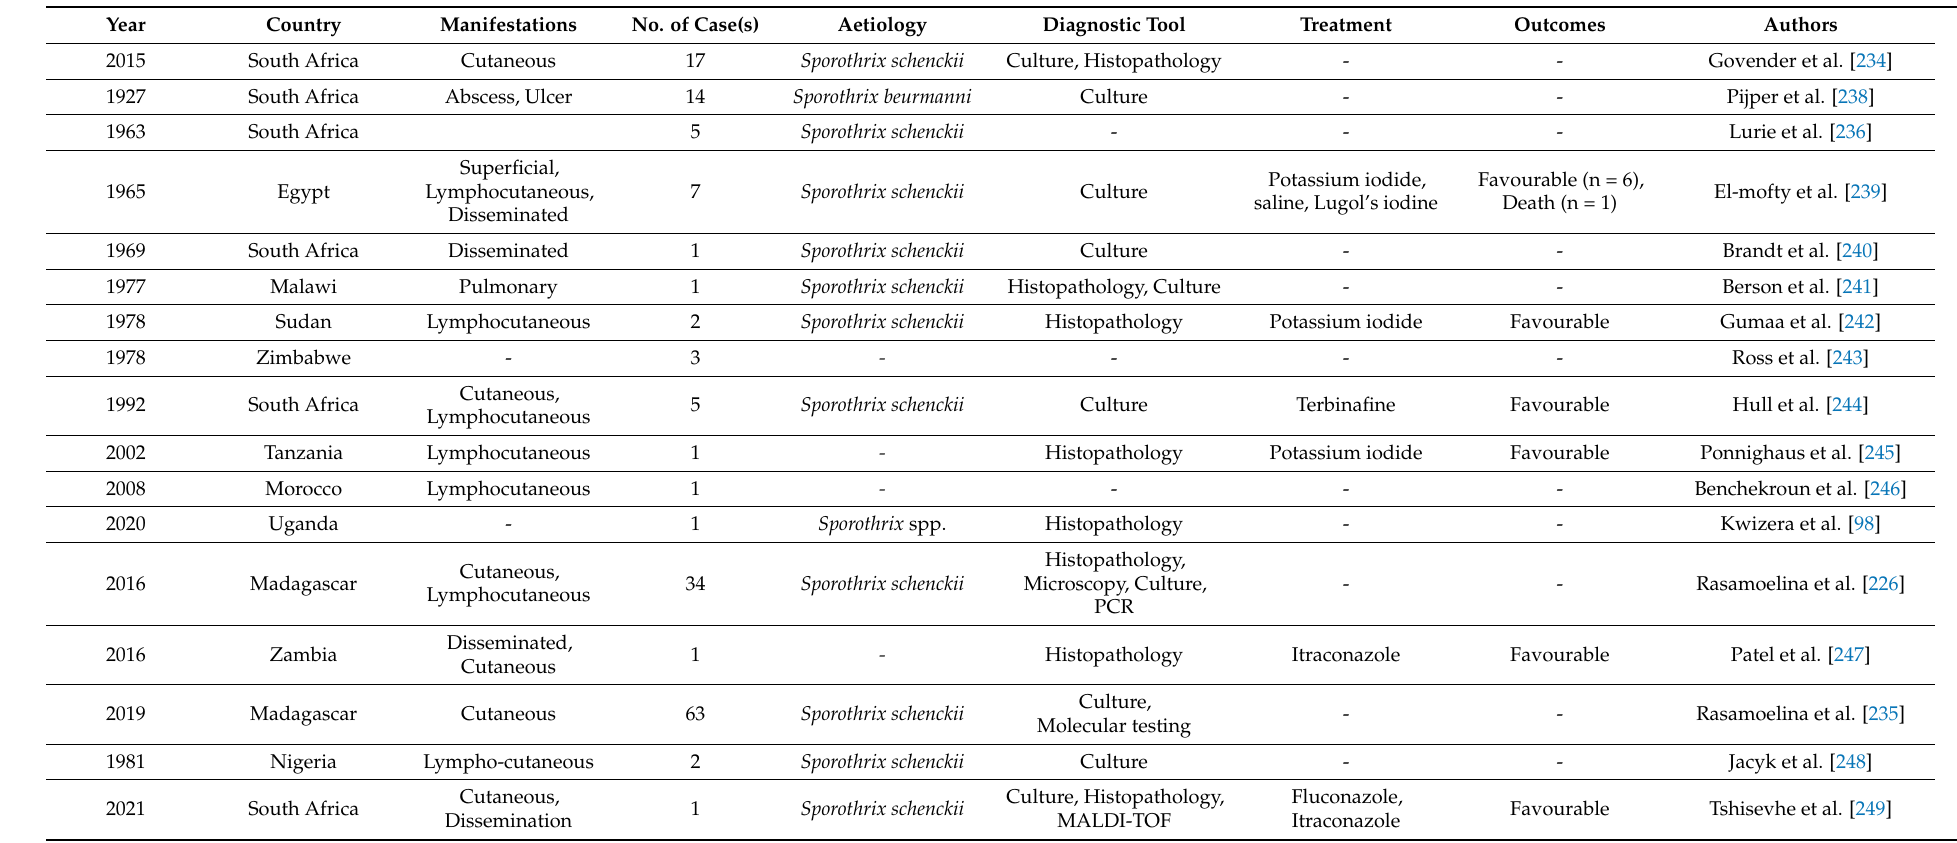
Table 12. Published cases of sporotrichosis in